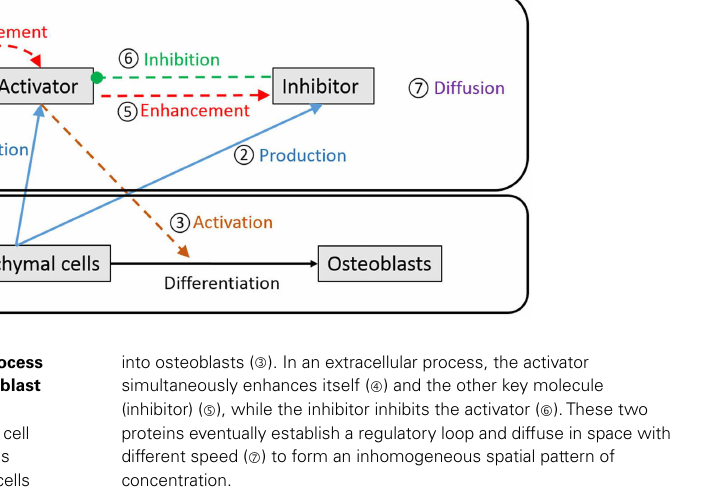
model ( Figure 3 , (cid:129) and ‚ ). The activator initiates chemical